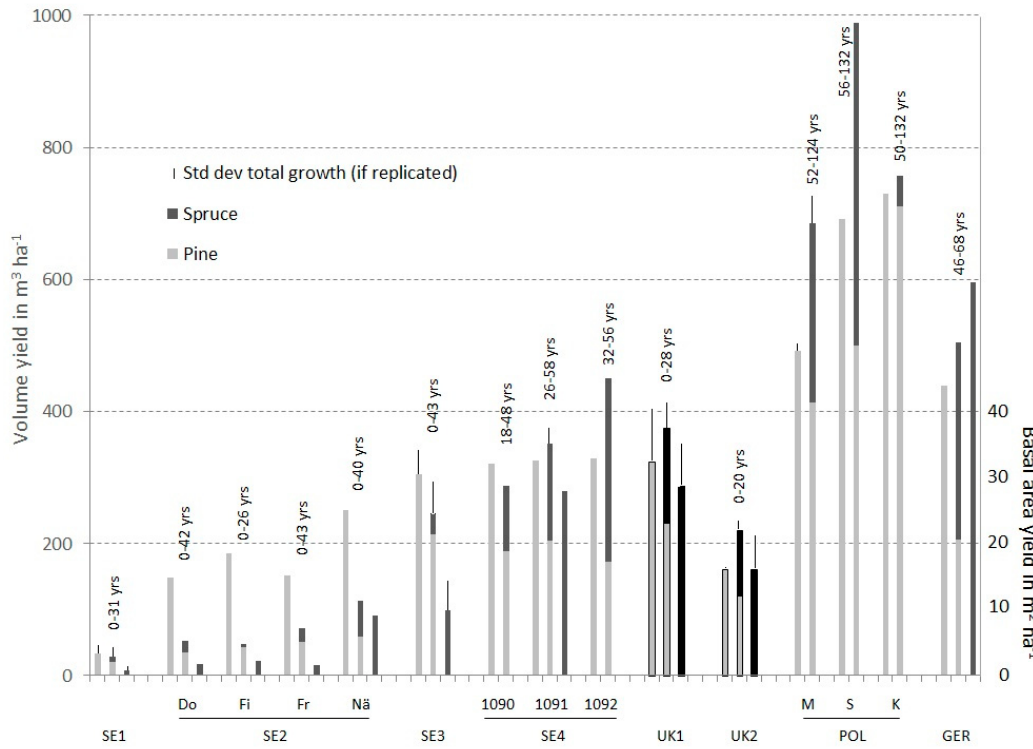
Figure 2. Cumulative production from the first to last measurements of the experimental sites (volume growth for SE, POL, GER in grey bar color, or basal area growth in UK with black color or contour). The three bars per study site illustrate the production achieved in the three different treatments: pine (left bar in light grey), tree species mixture (center), and spruce (third bar to the right, if available on the site). The lines above the bars indicate the standard deviation if the treatment was replicated on the site (see number of observations in Table 1). The numbers above the bars show the stand age covered by the observations.